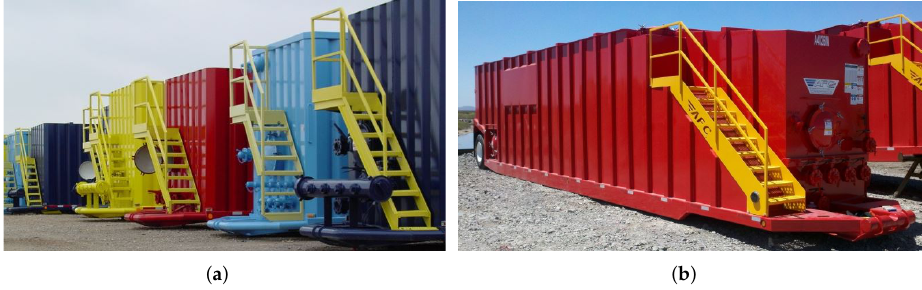
Figure 1. Typical holding tanks for hydraulic fracturing with lateral reinforcement and auxiliary